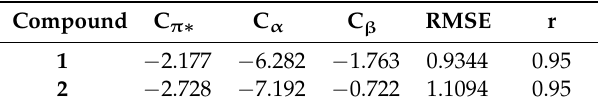
Table 5. Adjusted coefficients (C π * , C α and C β ), root mean squared error (RMSE) and correlation coefficients (r) for the Multiple Linear Regression analysis of the absorption λ max of the compounds 1 and 2 with the solvent polarity/polarizability and the acid and base capacity using the Kamlet-Abboud-Taft ( π *, α and β ) scale.